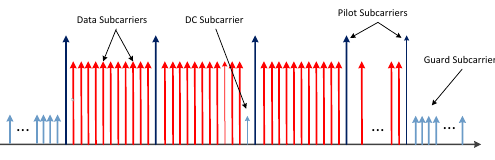
Figure 5. OFDMA Subcarrier